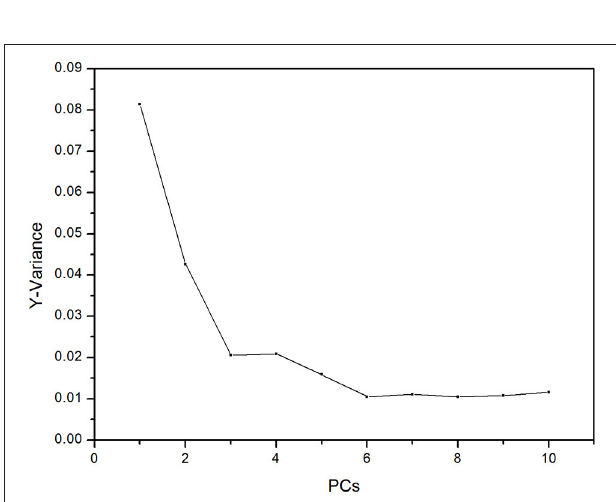
FIGURE 6 | PLS-DA Y-variance plot in the 1,750–900 cm − 1 spectral region.